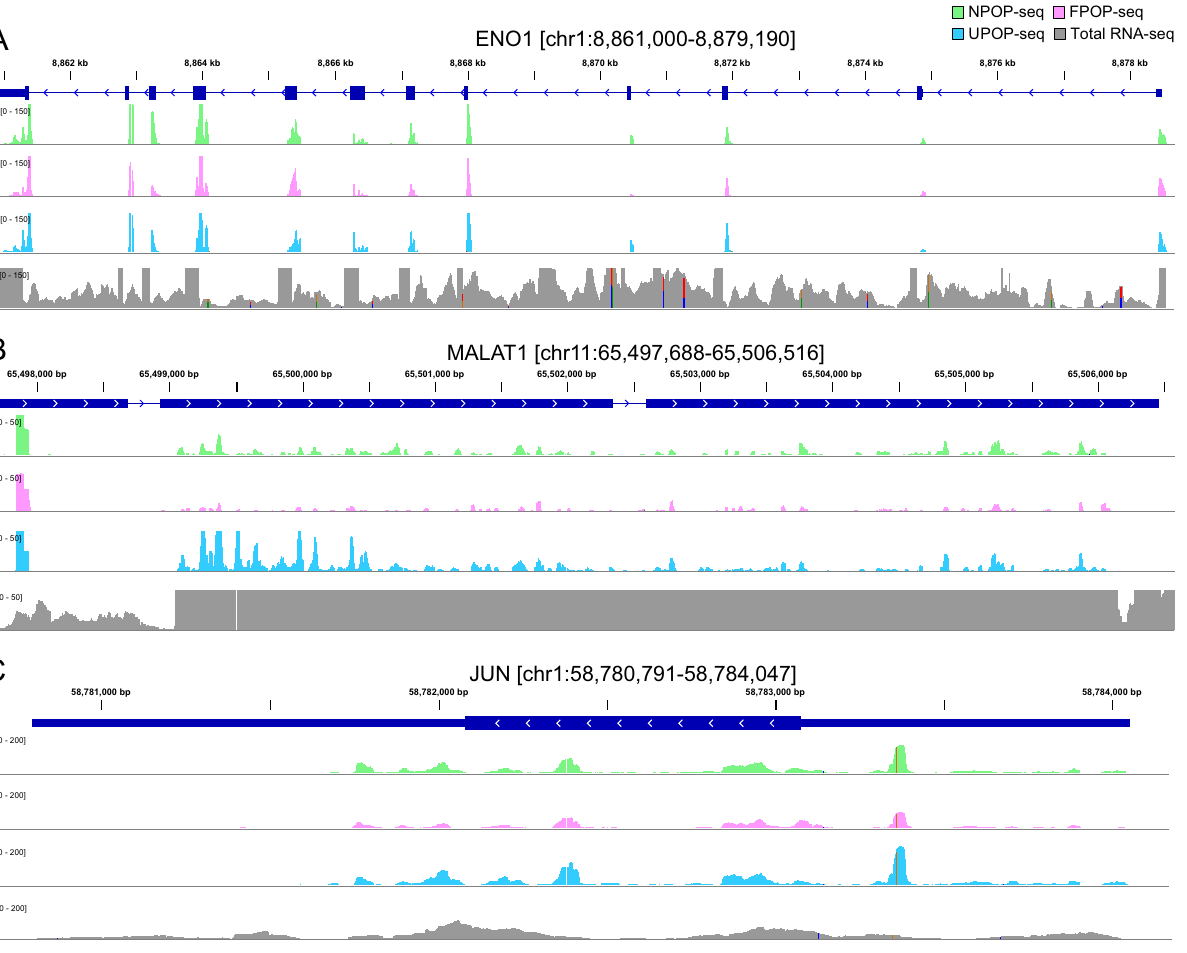
Figure 5. Genomic tracks showing the POP-seq peaks spanning the genomic loci of regulatory genes; ( A ) RBP – Enolase1 (ENO1) ( B ) LncRNA – MALAT1 and ( C ) transcription factor – Jun. Total RNA-seq data (from K562 cells) is included in the track as a background control (Y-axis adjusted to POP-seq scale).